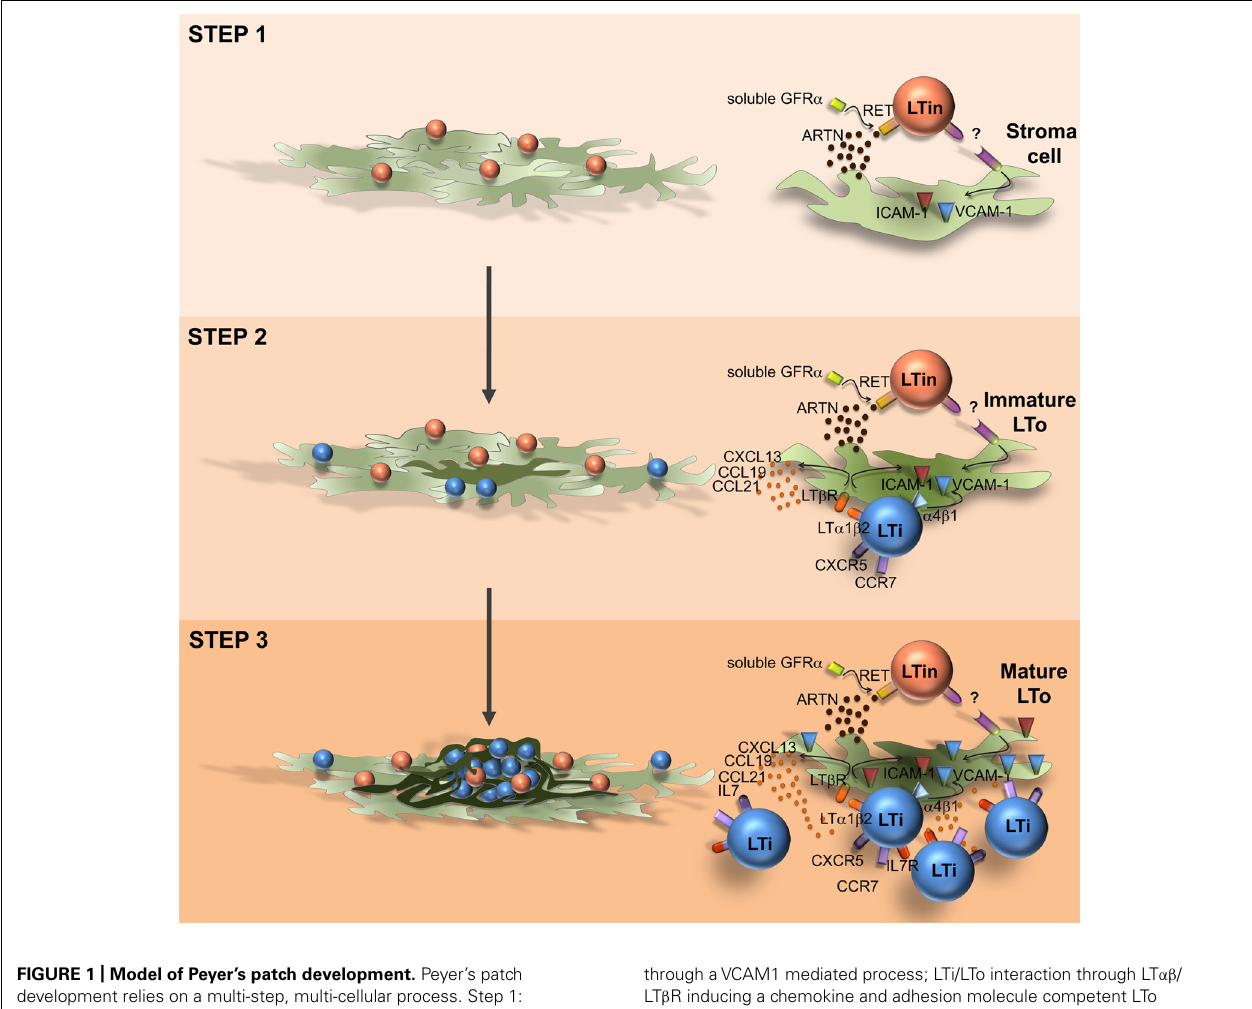
FIGURE 1 | Model of Peyer’s patch development. Peyer’s patch development relies on a multi-step, multi-cellular process. Step 1: RET-dependent, adhesion-dependent interaction between LTin and mesenchymal cells, results in stroma cell priming andVCAM1 induction (immature LTo cell). Step 2: retention of resident LTi cells